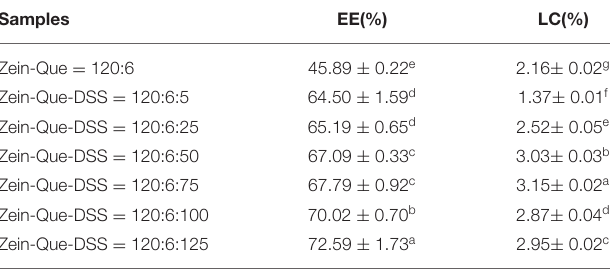
1 Results are means ± SD (n = 3). Different superscript letters in the same column represent significant differences (p < 0.05).